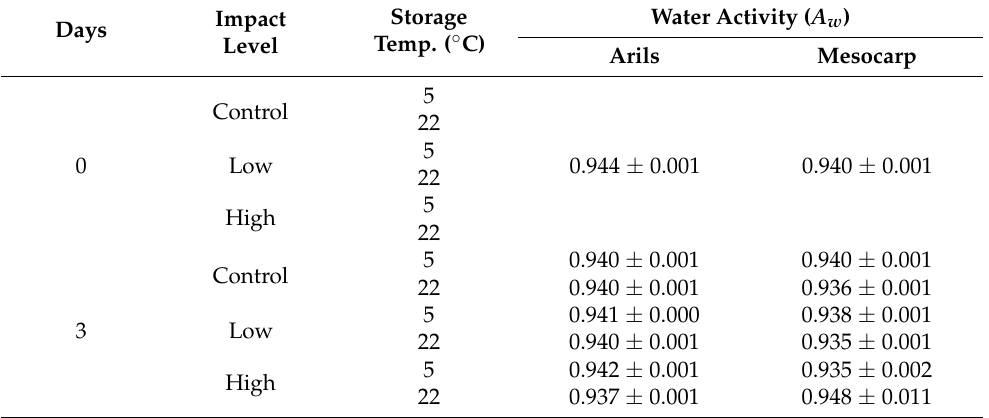
Table 3. Water activity ( A w ) of arils and mesocarp fractions of non-bruised, low-impact (45 ◦ ; 1.18 J), and high-impact (65 ◦ ; 2.29 J) bruised pomegranate fruit over 28 days of storage at 5 ◦ C and 22 ◦ C. The values are presented as standard deviation (SD) of the mean values of six readings per two replicates of each group